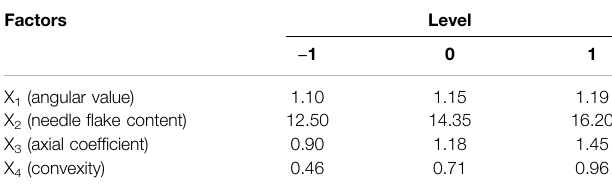
TABLE 4 | Response surface test factor level.